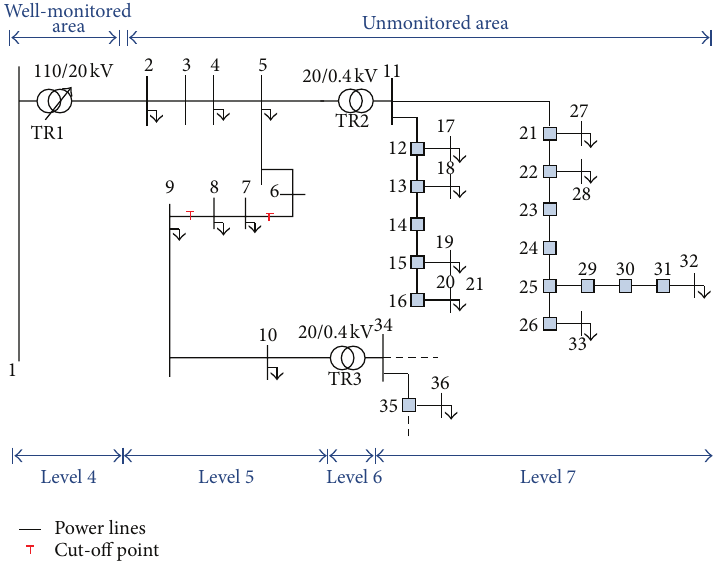
Figure 8: Reference